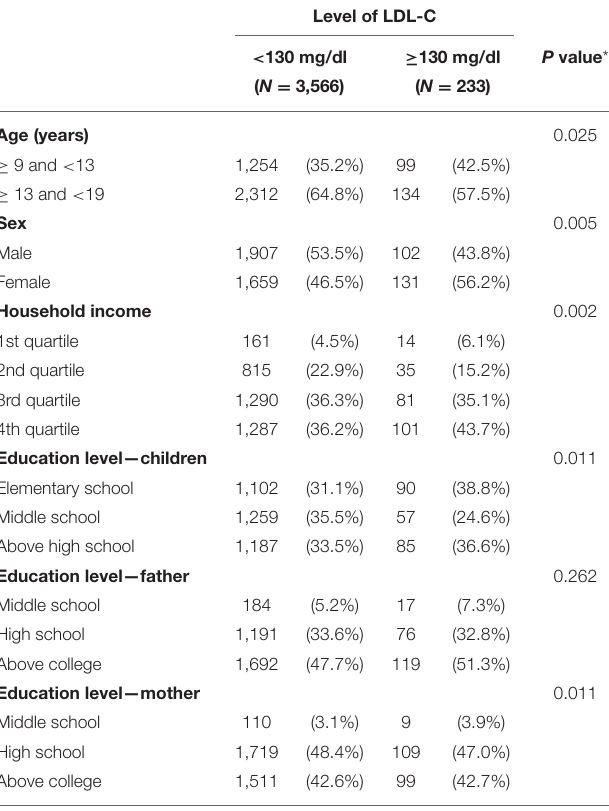
TABLE 1 | Baseline characteristics of study participants divided by low-density lipoprotein cholesterol (LDL-C)